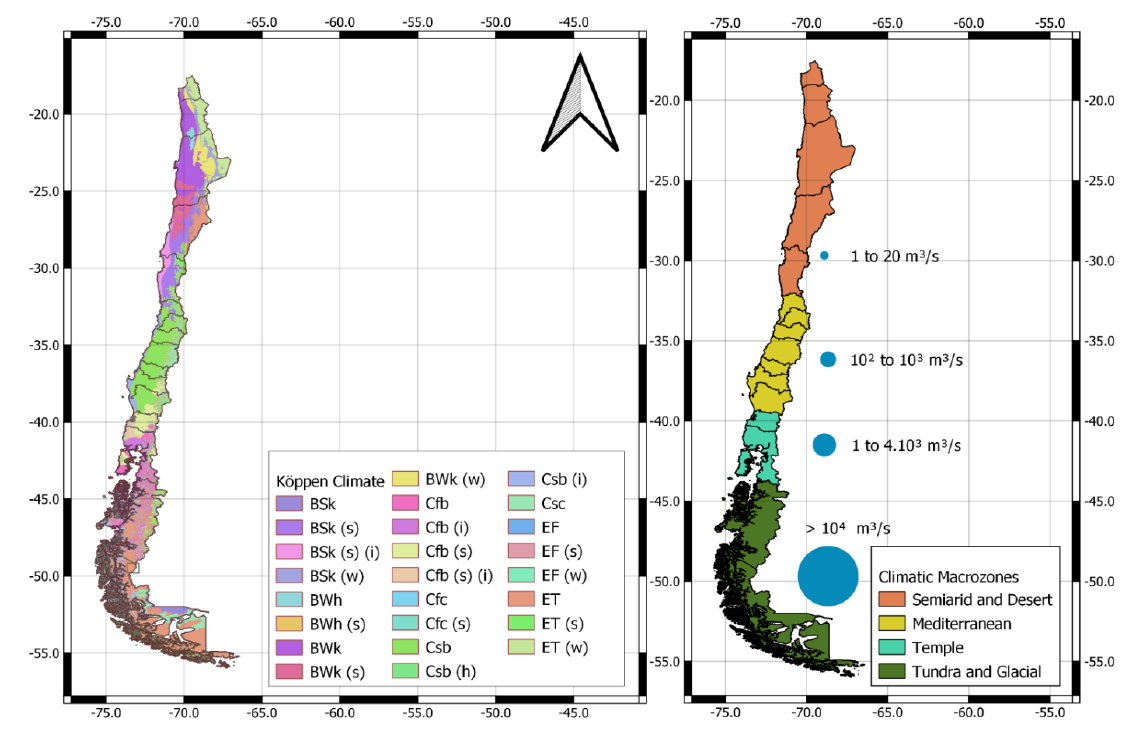
Figure 2. Geopolitical maps of Chile, with Köppen climatic classification (see Beck et al. [47] for details), on the left side, and climatic macrozones, on the right side. Water supply information (blue circles) based on Villamar et al. [34].